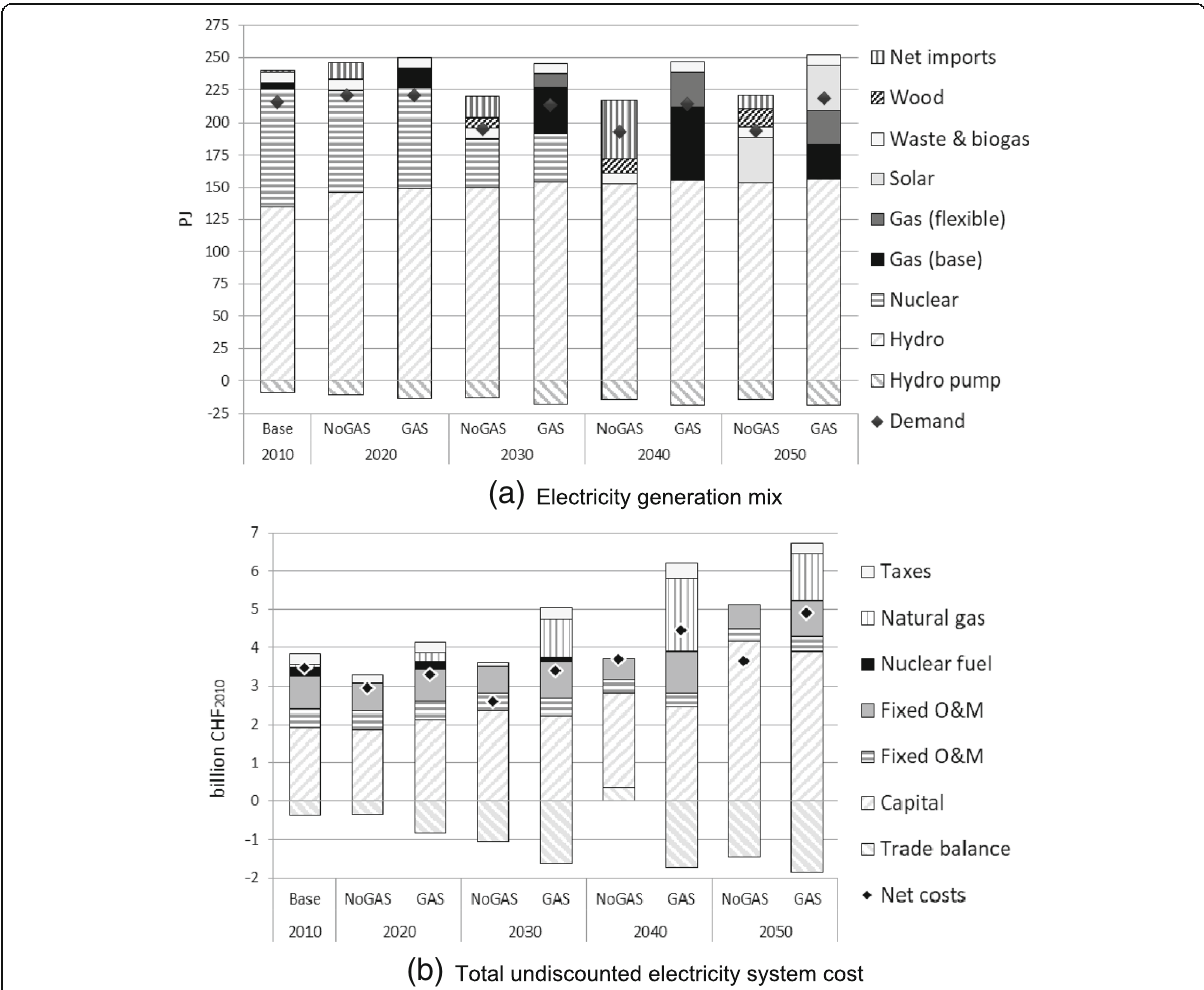
Fig. 3 Electricity generation mix and system